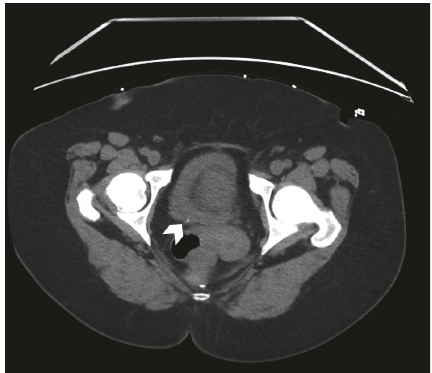
Figure 1: Axial CT scan of the abdomen and pelvis without contrast revealedanatrophicleftkidneyanda4mmstone(arrowhead)inthe right ureterovesical junction causing mild hydroureteronephrosis with findings suggestive of